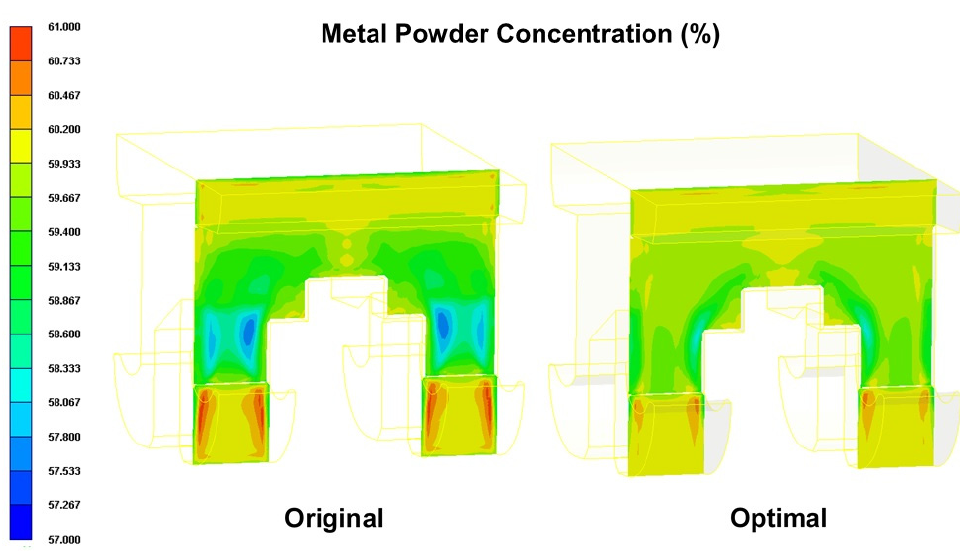
Figure 13. Comparison of metal powder concentration distributions in original process design and optimal process design.